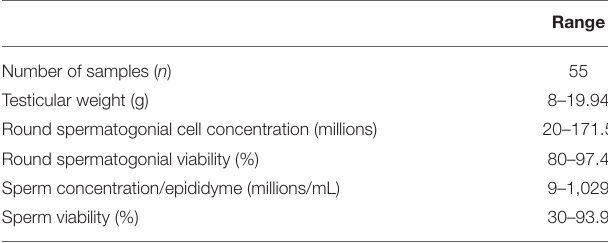
TABLE 1 | Samples characterization by parameter